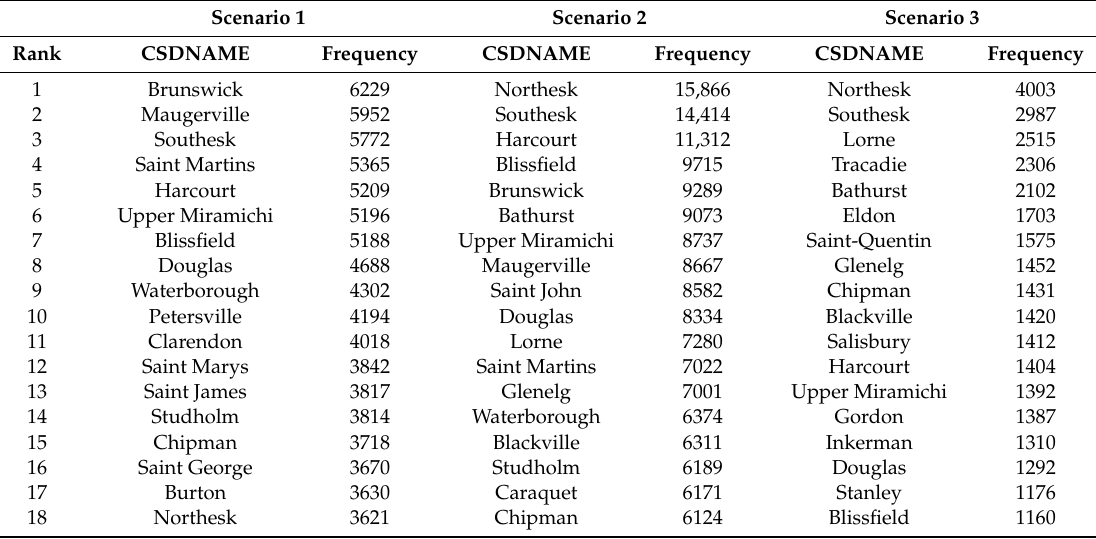
Table 6. Prioritization list based on frequency analysis with a very high flood